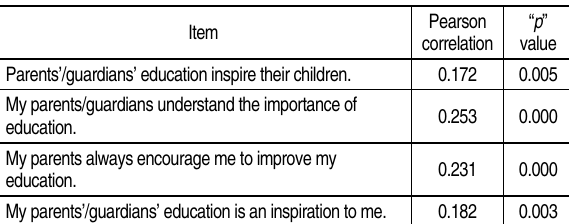
Table 6. Correlation of parents’ education and